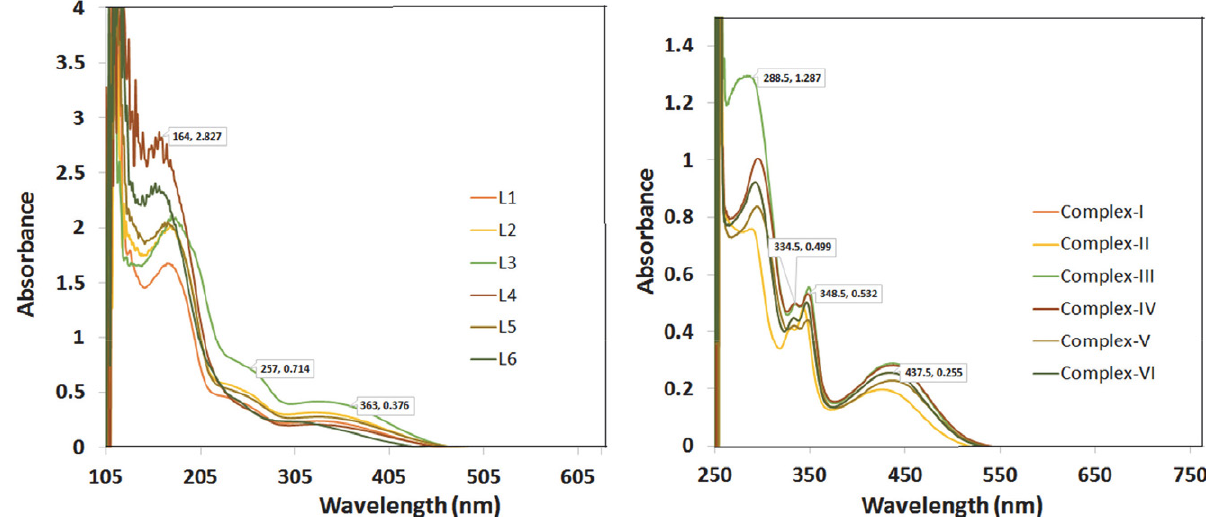
Figure 1. Electronic transition spectra of the ligands (L 1 -L 6 ) and complexes